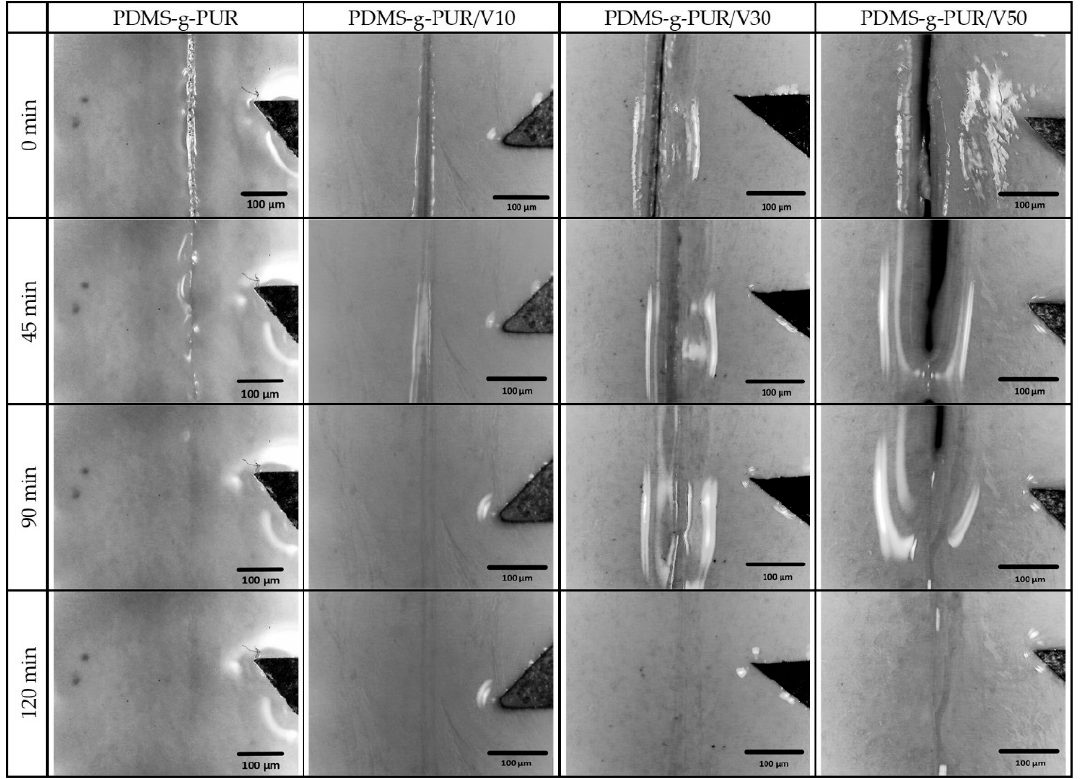
Figure 9. The optical microscope images of self-healing behavior of knife-cut PDMS -g- PUR and PDMS -g- PUR /V 2 O 5 composites as a function of healing time. The healing was done at 50 °C.